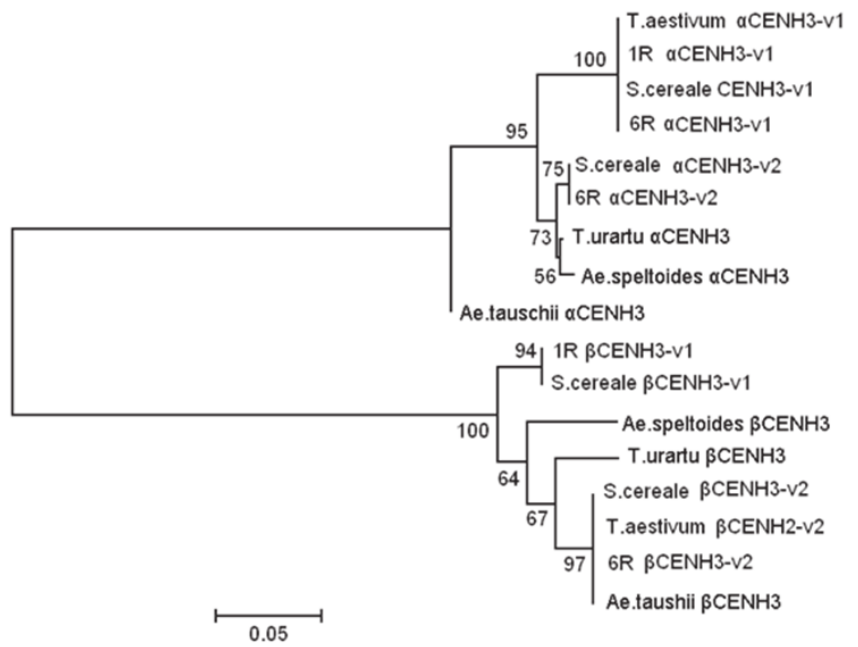
Figure 3. Phylogenetic tree of the CENH3 proteins. Phylogenetic tree inferred using JTT+G models (measures distances) and bootstrapping (1000 replicates). Bootstrap values are indicated on the branches. Rye S. cereale (cv. Imperial), wheat T. aestivum (cv. Chinese Spring) and wheat-rye (1R–7R) addition lines. NCBI accessions are: α CENH3 and β CENH3 in T. urartu (KM507181, KM507184), Ae.